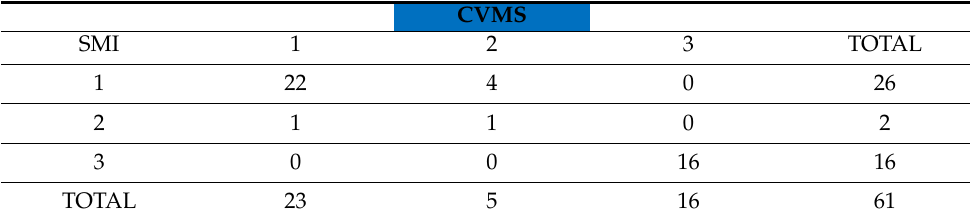
Table 3. The result of the Cohen’s kappa coefficient for the group of